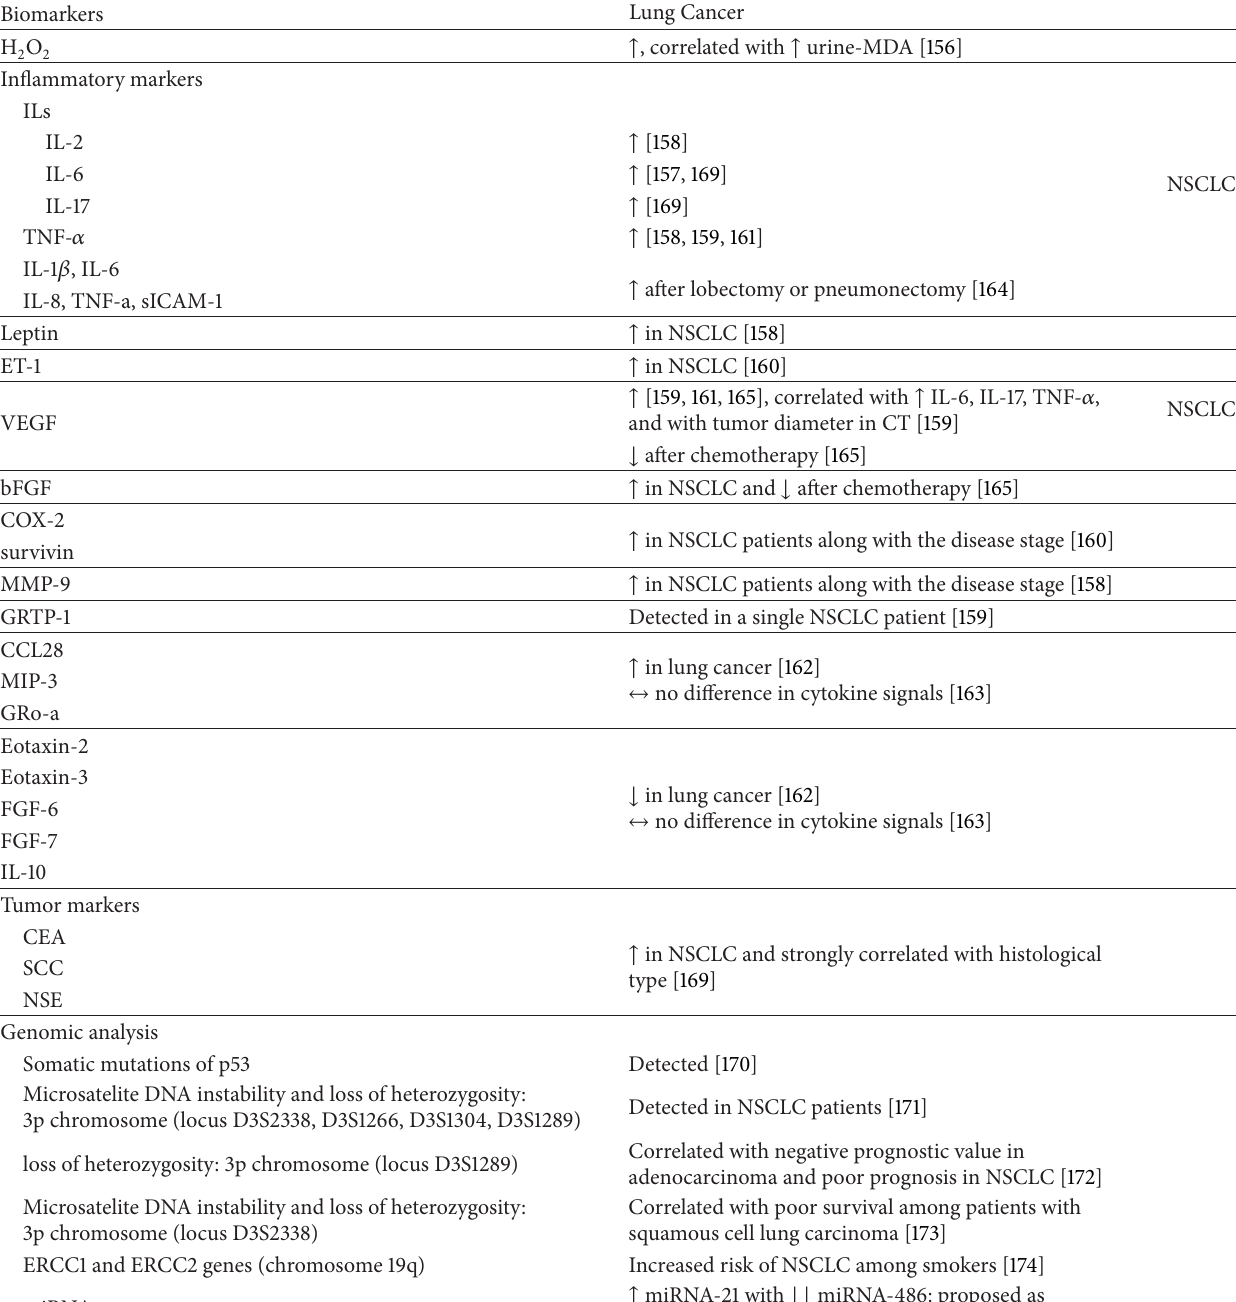
Table 4: Exhaled breath condensate biomarkers in lung